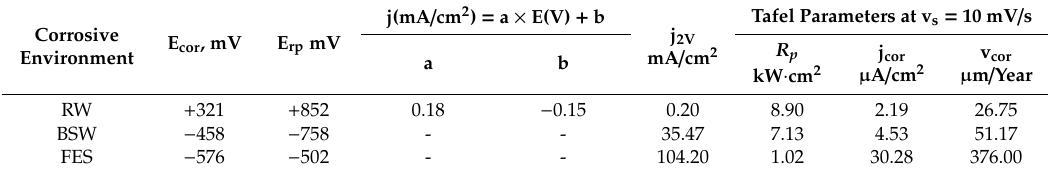
Table 14. Comparison between corrosion rates (v cor -in µm/year) for the OPS sample.